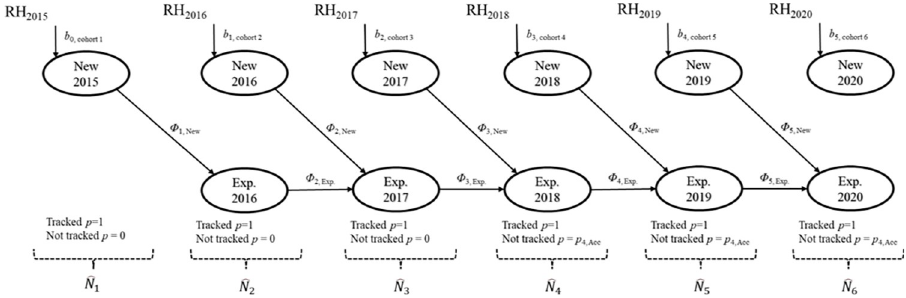
Fig 2. Simplified conceptual framework of the Jolly-Seber open population model used to estimate abundance and survival of headstarted Blanding’s Turtles in the Rouge National Urban Park. The analysis included 260 released headstarted turtles, of which 139 had capture histories from mark-recapture and radio-telemetry surveys. Survival and detection parameters were indexed by time and by acclimation (acc), which had two levels: ‘New’, for newly released turtles and Exp. (experienced) after more than one year in the wild. Probability of entry ( b ) was indexed by time and release cohort. b 0 occurs prior to the first sampling occasion. RH year refers to the size and year of each release. ^ N ^ refers to population size in each year. Implementation of this model included partitioning of release cohorts t into smaller groups according to telemetry duration so that detection probability, p , could be fixed at 1 on specific occasions when turtles were